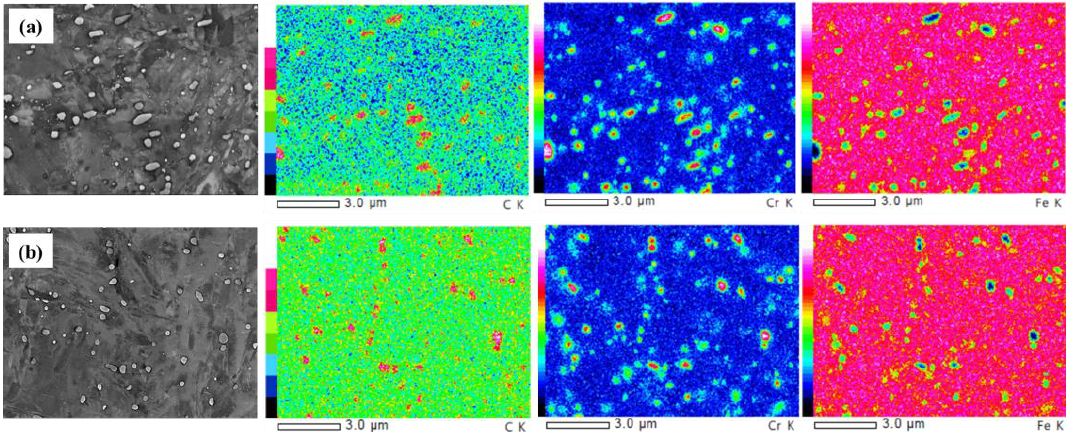
Figure 3. Scanning electron microscopy-energy-dispersive spectroscopy ( SEM-EDX) map showing carbon and chromium enrichment and iron depletion on precipitates. ( a ) specimen A; ( b ) specimen B. Online version in color.